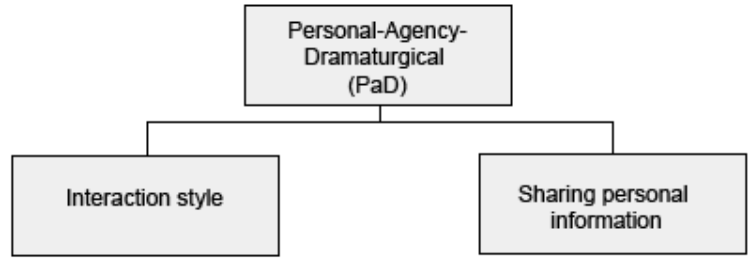
Figure 6 . Personal agency-dramaturgical